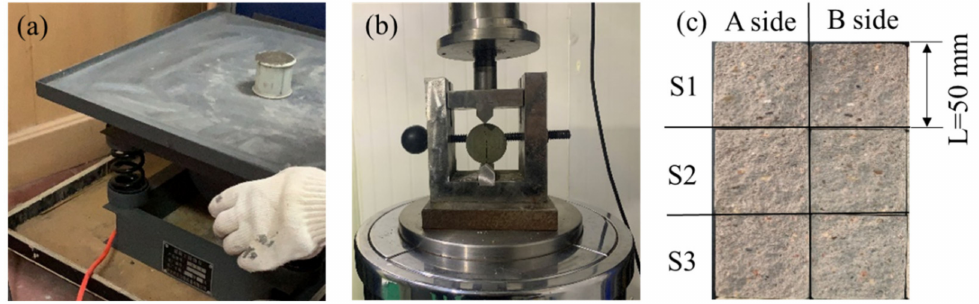
Figure 3. Process of samples preparation. ( a ) Pouring cement samples, ( b ) Brazilian splitting test and ( c ) numbering of fracture surfaces.